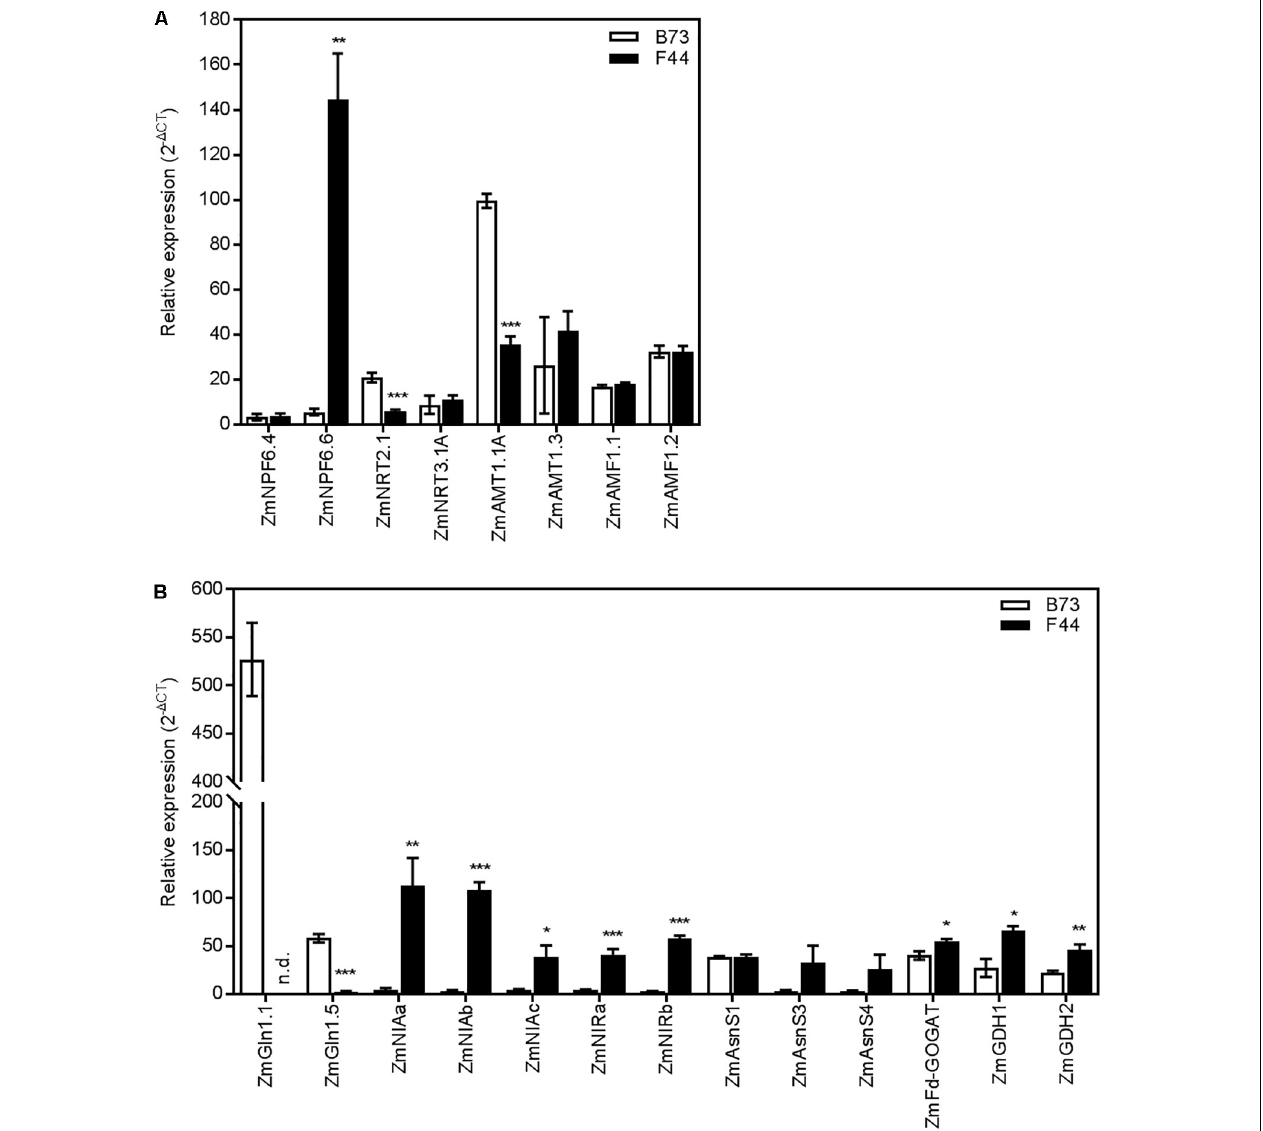
FIGURE 3 | Gene expression in B73 (white) and F44 (black) roots. (A) Expression of nitrogen transporter genes. (B) Expression of nitrogen metabolism pathway genes. Values are means ( ± SE) from three individual plants. Similar results were obtained in another independent experiment. Asterisks indicate significant differences between lines at ∗ P < 0.05, ∗∗ P < 0.01, ∗∗∗ P < 0.005 (Student’s t -test). NPF/NRT, nitrate transporter; AMT, ammonium transporter; AMF, ammonium facilitator; GLN, glutamine synthetase; NIA, nitrate reductase; NIR, nitrite reductase; AsnS, asparagine synthetase; GOGAT, glutamate synthase; GDH, glutamate dehydrogenase; n.d.,